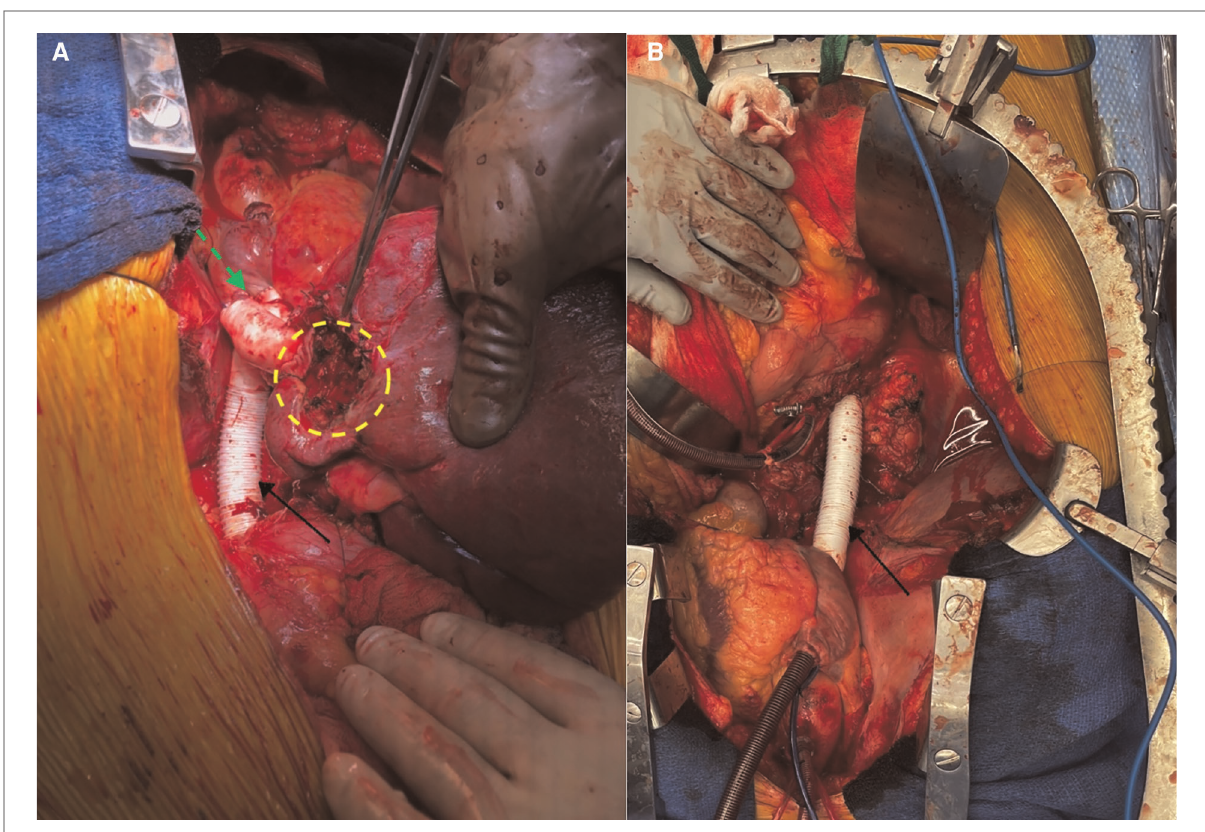
FIGURE 4 ( A ) Intraoperative view of the various graft reconstructions. Dotted green arrow=site of hepato-atrial anastomosis; dotted yellow circle=region of excised tumor; solid black arrow=vena caval GTX graft. ( B ) Vena caval graft (solid black arrow) before liver re-implantation. GTX,